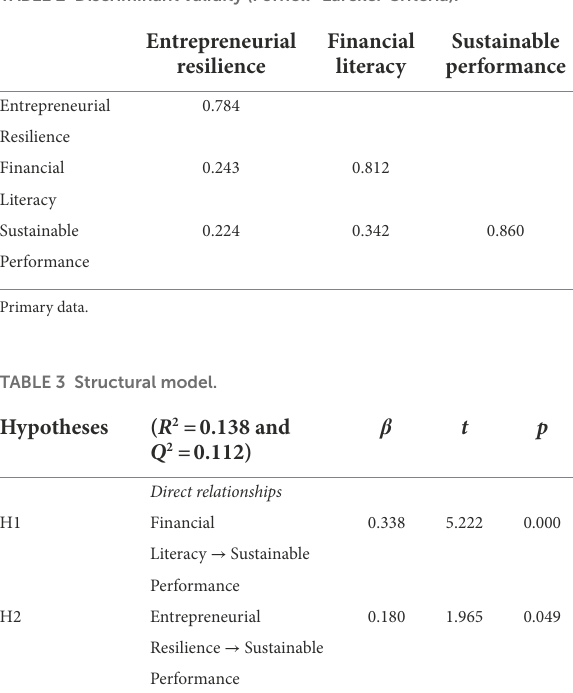
Table 3. The endogenous constructs R 2 values were used to assess model fit and determine how well data points match a line or curve. According to Chin (1998), R 2 levels can be classified as small (0.02 < R 2 < 0.13), medium (0.13 < R 2 < 0.26), or large (0.26 < R 2 ). The endogenous constructs’ R 2 statistic values were